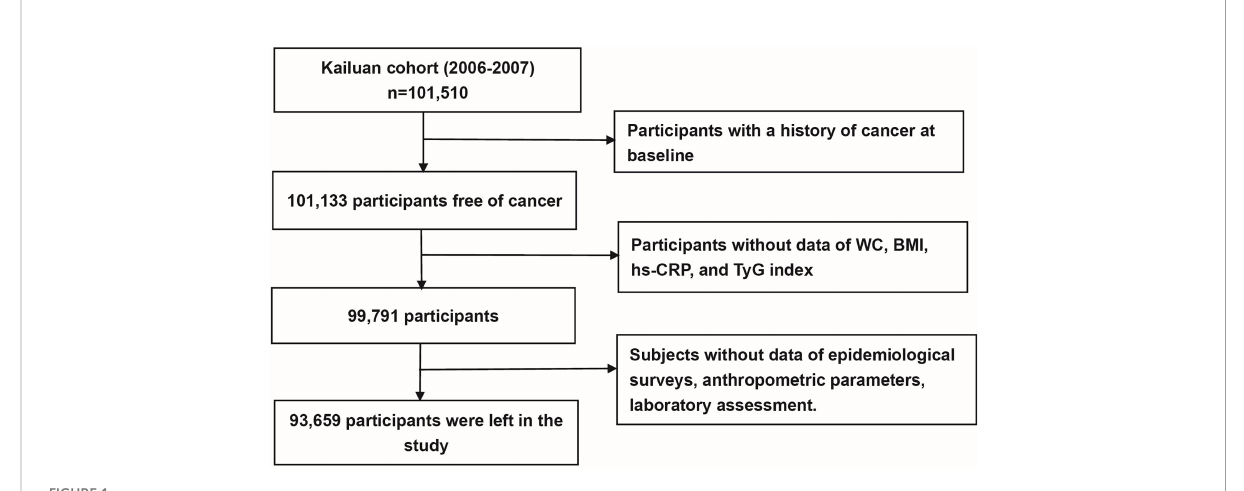
FIGURE 1 Flow chart of study